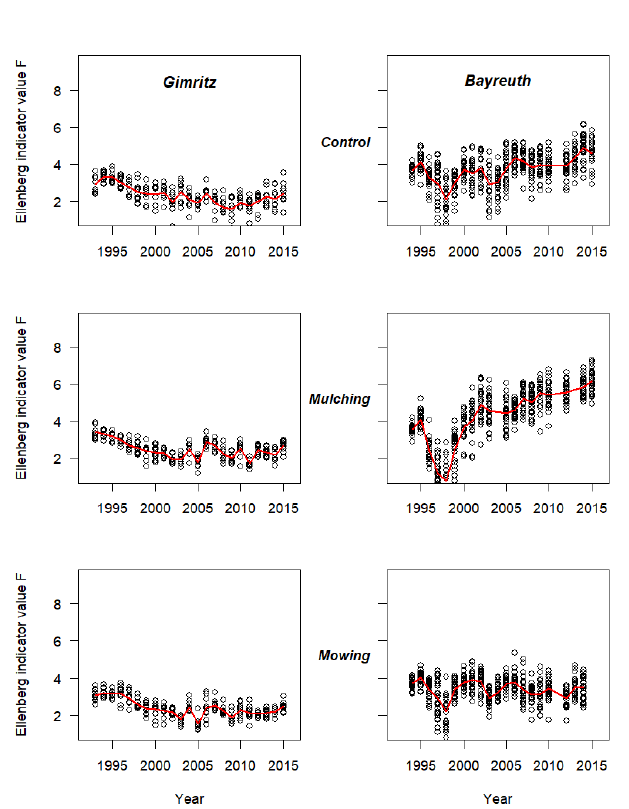
Figure 3. Mean indicator value for soil moisture ( F -value) of sub- plots within each treatment plotted versus years for the study sites Gimritz and Bayreuth (see also Table 3). The red shows the mean across